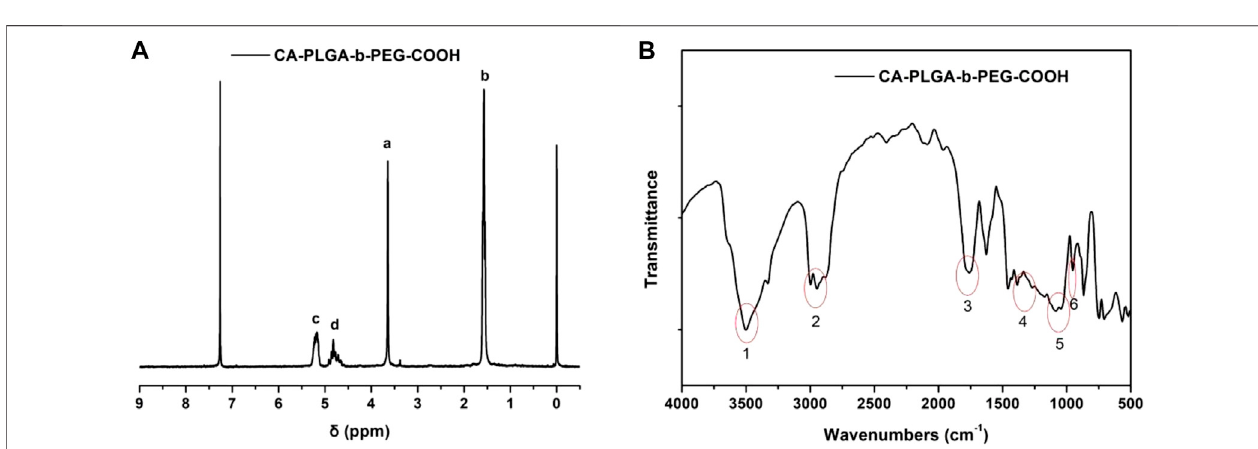
FIGURE 2 | Typical characterization of copolymer CA-PLGA- b -PEG-COOH (A) 1 H NMR spectra; (B) FT-IR spectra.